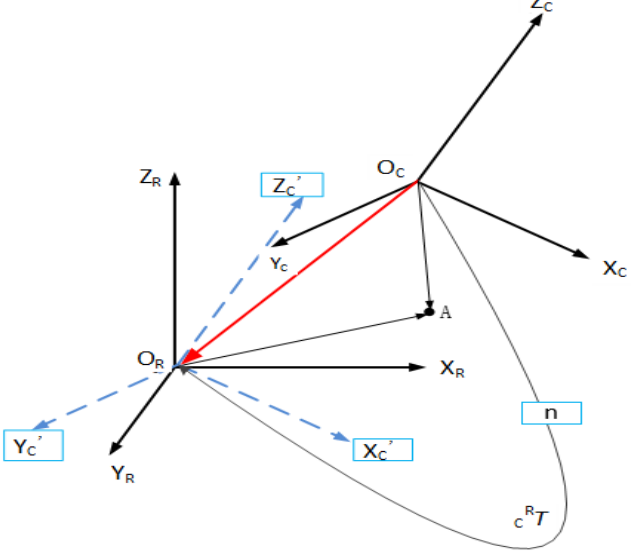
Figure 5. Coordinate system transformation .